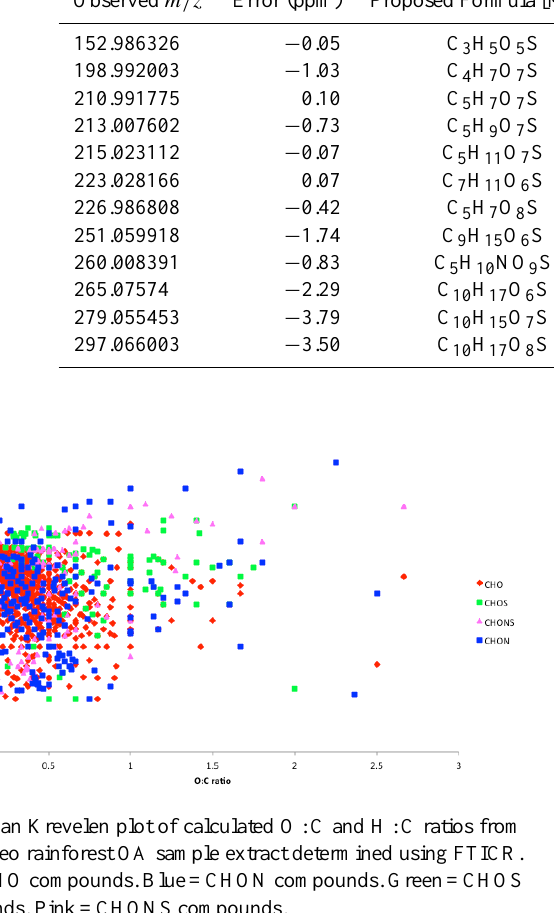
Table 3. Isoprene and monoterpene organosulfates identified using FTICRMS in ambient aerosol collected atDanum Valley, Borneo. Observed m/z Error (ppm) Proposed Formula [M-H] − O:C